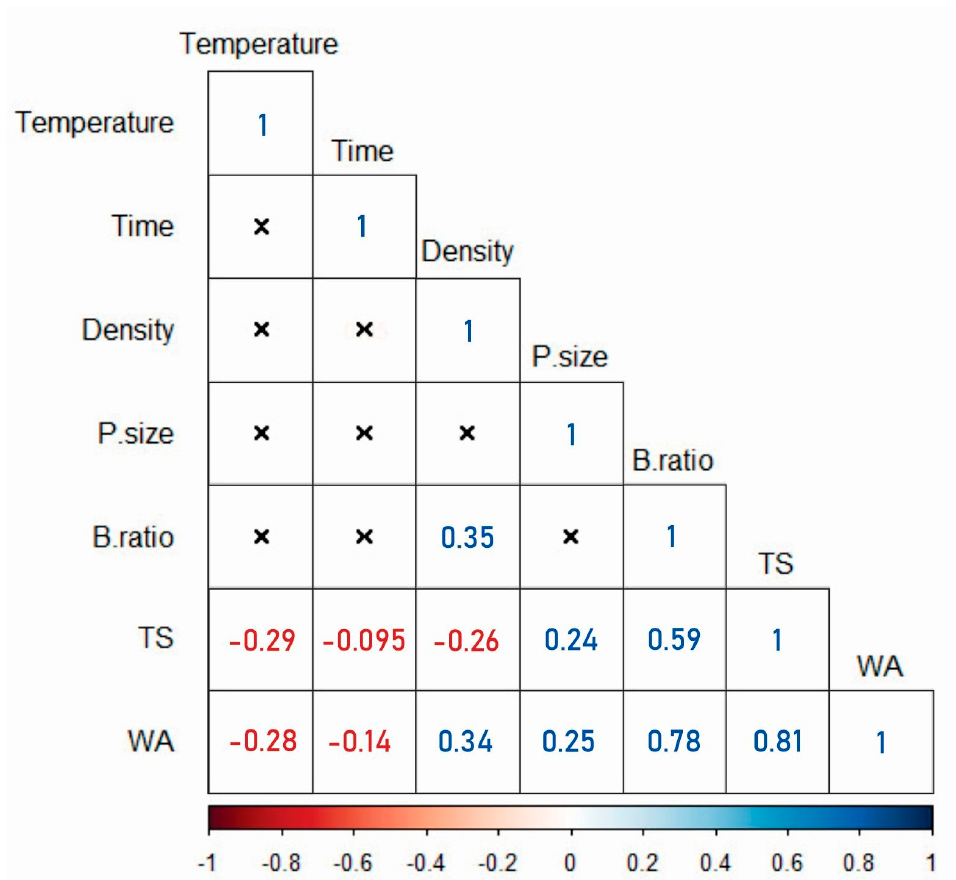
Figure 9. Pearson’s R correlations of the impact of independent press parameters on the physical properties (WA, TS and density) of WPCs. The correlation matrices marked (x) are not significant or inapplicable.